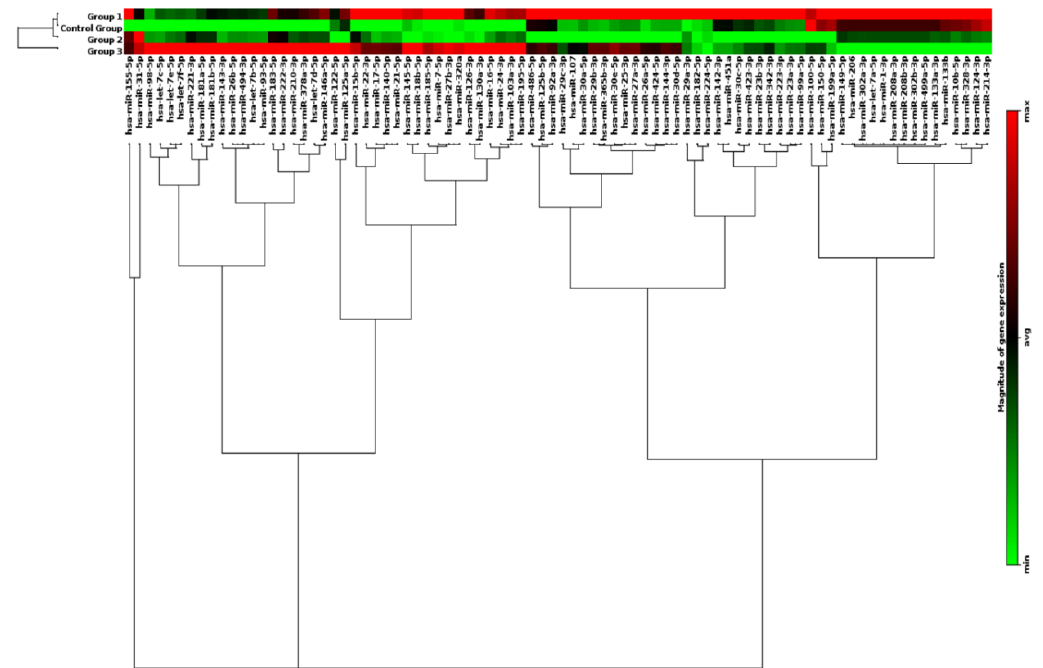
Figure 7. Profile of circulating miRNAs in CAD patients. MiRNA Heat Map illustrates differential expression between groups stratified by the presence or absence of CAD and risk assessment by FRS. Color intensity is scaled within each row such that the highest expression value corresponds to bright red, and lowest to bright green. CAD—Coronary Artery Disease. FRS—Framingham Risk Score.